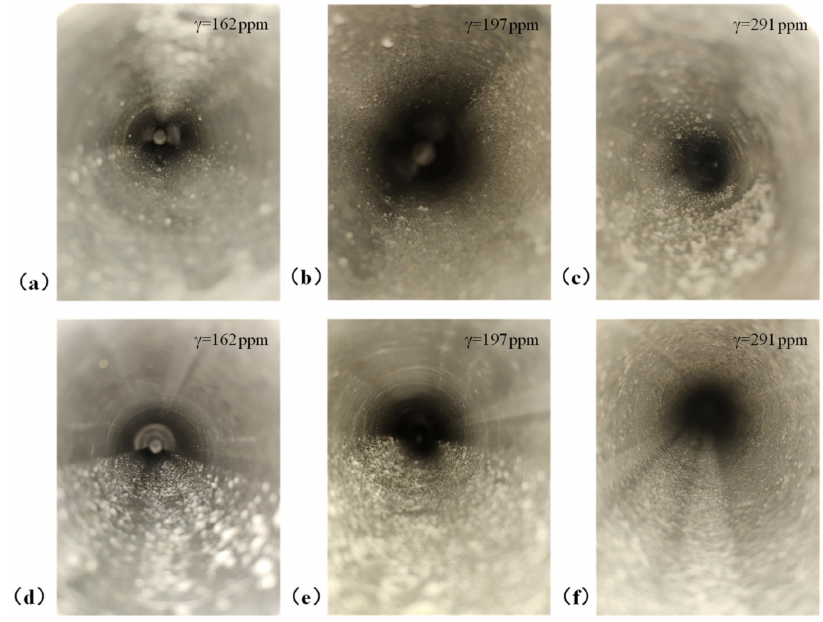
Figure 10. Ice accreted in the test-sections at varied water concentrations for t = 2 h, T f = − 12 °C, V = 600 L/h. ( a – c ) are the ice accretion at upstream test section and ( d – f ) are the ice accretion at downstream test